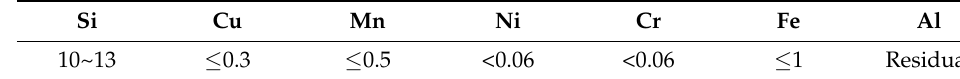
Table 1. Composition of ZL102 alloy (%).